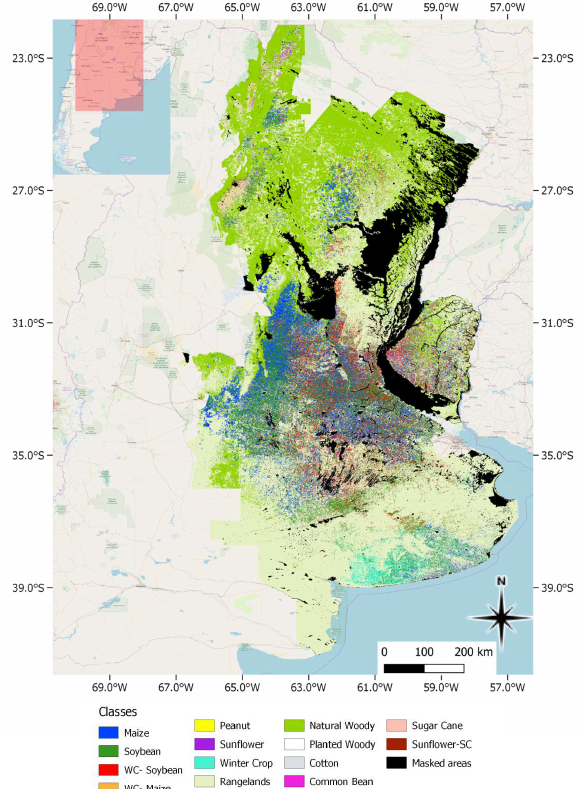
Figure 3. Cropland and crop type map of main agricultural areas of Argentina for the 2018/2019 growing season. Classes are described in Table